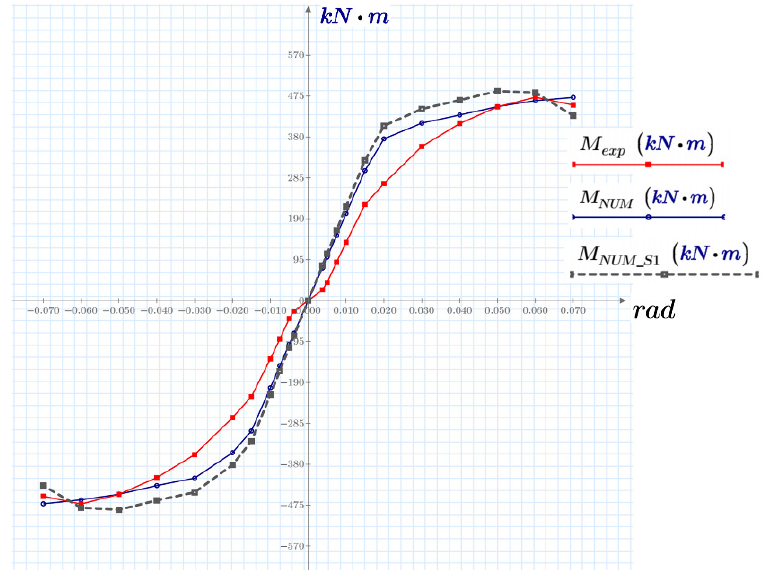
Figure 14. Comparison between the envelope curves obtained for the experiments ( M exp ), the numerical model defined originally ( M NUM ) and the numerical model after the first simplification ( M NUM_S1 ).